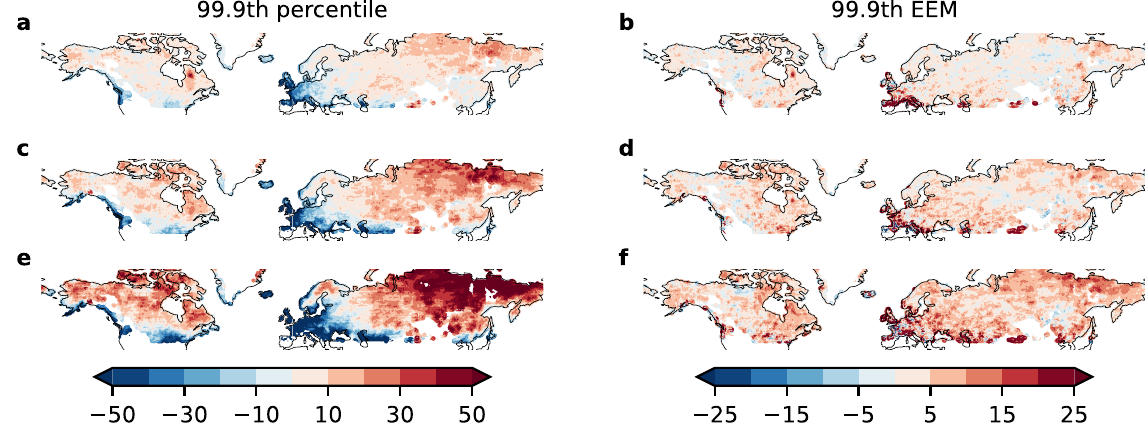
Figure 1. Intensification of extreme daily snowfall throughout the century for high-latitudes, decreasing percentiles, particularly in the second half of the century for mid-latitudes, especially Western Europe. Values are relative to the historical baseline (1851–1920). Relative change (in %) of ( a , c , e ) 99.9th percentile, and ( b , d , f ) 99.9th expected extreme magnitude; ( a , b ) 2021–2030, ( c,d ) 2051–2060, ( e , f ) 2091–2100. Maps created using the cartopy 0.17 24 library based on GSHHG shapes 25